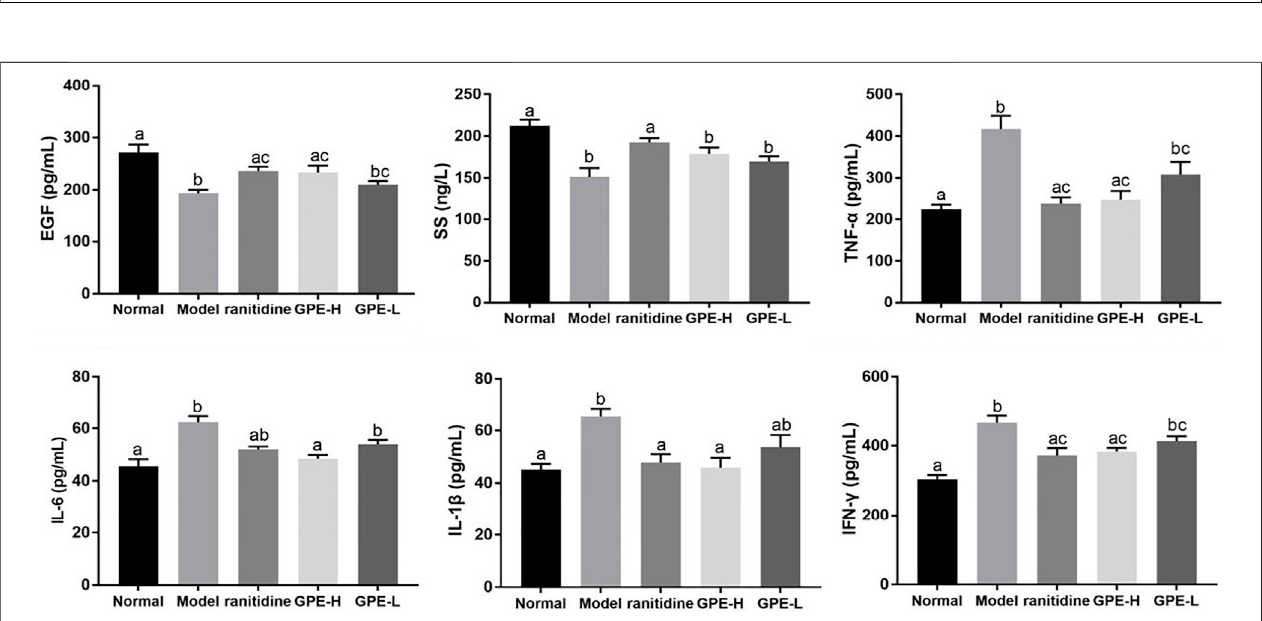
FIGURE 6 | Serum levels of EGF, SS, TNF- α , IL-1 β , IL-6, and IFN- γ in mice. The data are shown as mean ± SD (n (cid:2) 8). a – c Mean values with different letters are signi fi cant difference ( p < 0.05) according to analysis of variance.